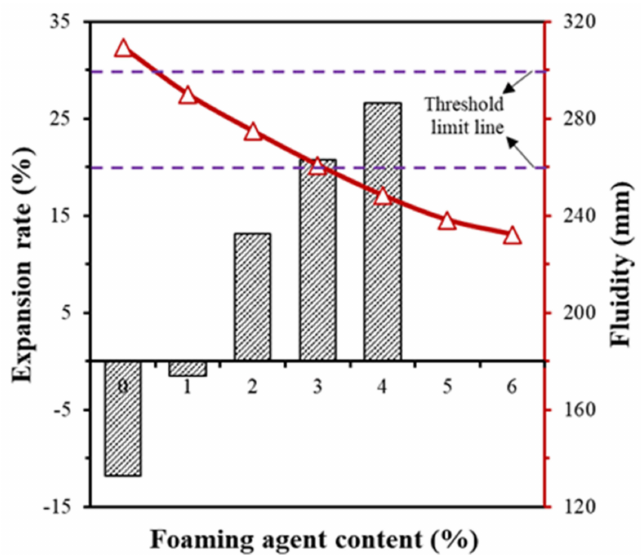
Figure 7. Effect of foaming agent on expansion rate and fluidity of FCPB. As foaming agent content increased, the fluidity of the fresh FCPB decreased approxi- mately linearly. Compared with the fluidity of fresh FCPB without a foaming agent, the fluidity of that with a foaming agent content of 4% decreased by 17.33%. When the foaming agent content was >4%, the degradation effect of the foaming agent on fluidity slightly decreased. The decrease in fluidity with increased foaming agent content can be partially explained by the water film thickness theory, i.e., the bubbles generated by the foaming agent increased the spacing among the solid particles, which in turn led to increased amounts of void filling water, thus reducing the water film thickness [52]. The ideal fluidity for transporting fresh backfill in a mine is ~260–300 mm [53]. Hence, considering a better roof-contacted filling effect, the foaming agent content should be between 1% and